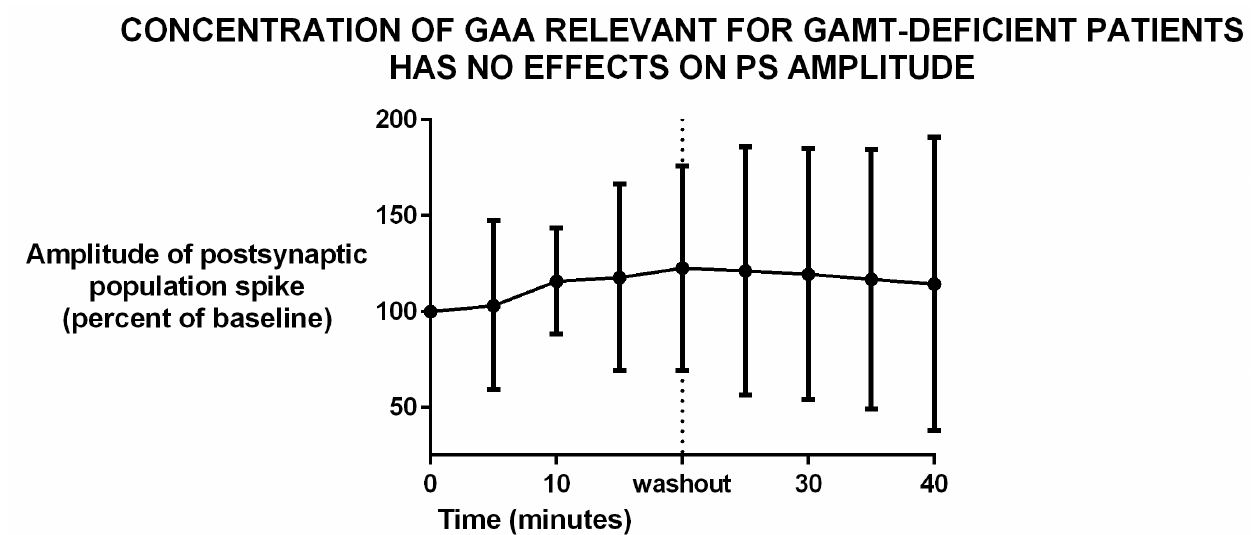
Figure 4. Incubation of brain slices with 11.5 µ M guanidine acetic acid (GAA) did not change the amplitude of the postsynaptic evoked potential (“population spike”). Data represent mean and standard deviation. N = 12. Differences are statistically not significant ( p = 0.98, analysis of variance). Slices were incubated with GAA for 20 min before washout. In most brain slices set up, including ours, this time is sufficient to allow exchange of chemicals to affect electrophysiological responses (personal data, not shown).